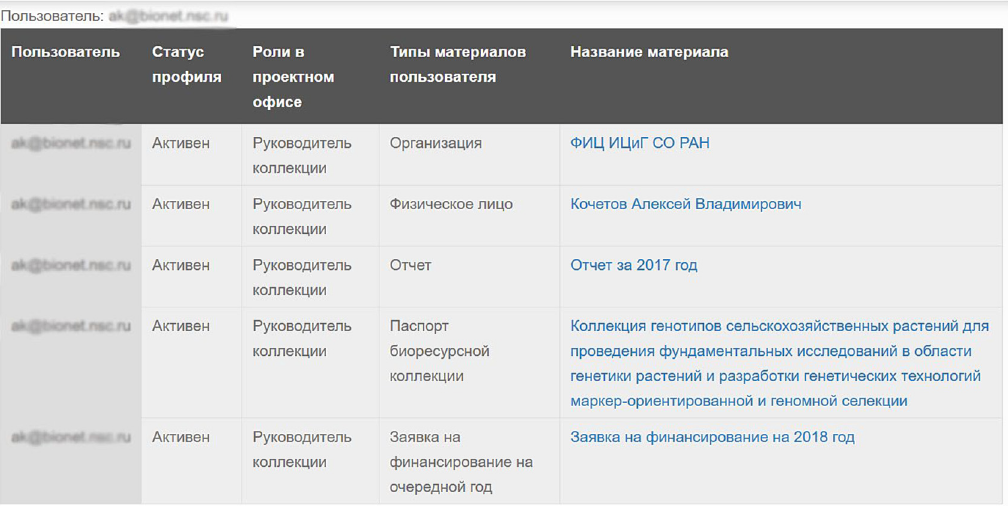
Figure 5: All types of materials of the project office (organization card, individual card, work report, collection passport and application for funding) tied to a separate collection. The manager of this collection has access to edit these materials.